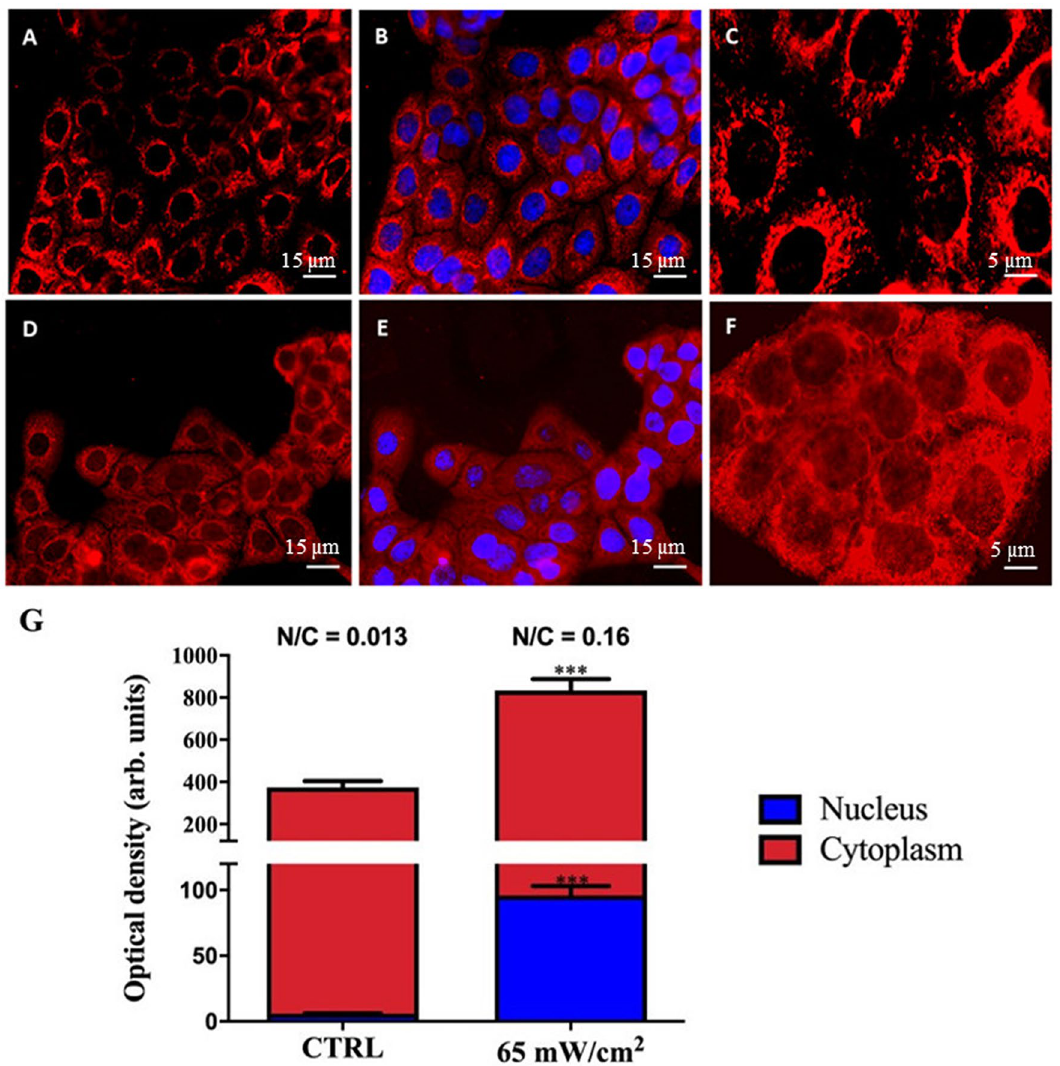
Figure 3. Immunofluorescence analysis of NF-κB activation in HaCaT cells exposed to 1 MHz US. HaCaT cells were stained with anti-p65 NF-κB (red) and Hoechst (blue). Representative images of the control sample ( A – C ) and of cells treated for 1 h at I spta = 65 mW/cm 2 ( D – F ) are reported. Scale bars measure 15 μm ( A , B , D , E ) and 5 μm ( C , F ). Densitometry measurements of the NF-κB immunofluorescent staining into the nucleus and into the cytoplasm are reported in panel ( G ). The ratio N/C between the two values is also reported above each column. The reported values and error bars represent the average and the standard deviation evaluated on ten different regions for each sample analysed. Asterisks indicate significant difference from control samples (***p < 0.001). The graph is representative of at least three independent